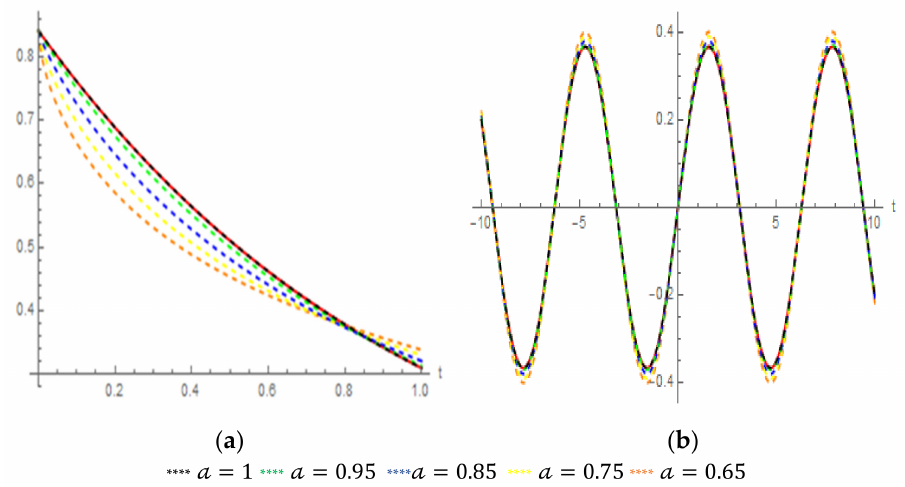
Figure 5. Plots of exact solutions ( U ( 𝓍 , 𝓉 ), V ( 𝓍 , 𝓉 )), and the 7-th approximate solutions ( U 7 ( 𝓍 , 𝓉 ), V 7 ( 𝓍 , 𝓉 )), for system (20) at various values of 𝒶 . ( a ) 𝓉